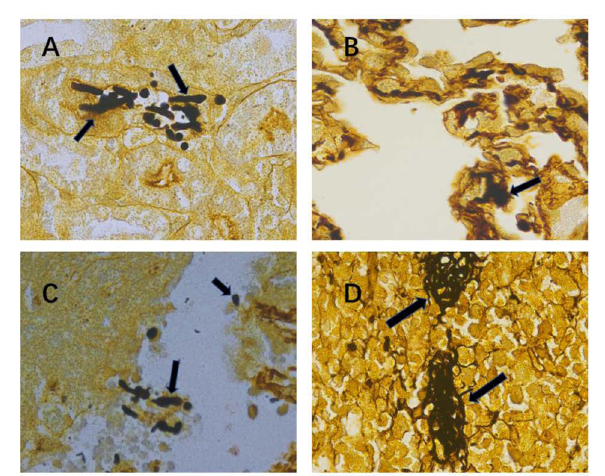
FIGURE 1 | Confirmation of severe invasive Candida albicans multiorgan infection mouse model. Representative kidney (A) , lung (B) , liver (C) and spleen (D) histological sections at 12 h after intravenous injection of C. albicans were stained with Gomori’s methenamine silver to visualize C. albicans hyphae and spores. Black arrows indicate hyphae and spores. Magnification, 1000 ×